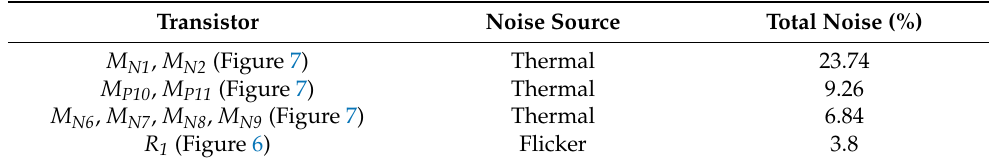
Table 5. Simulated noise contribution.